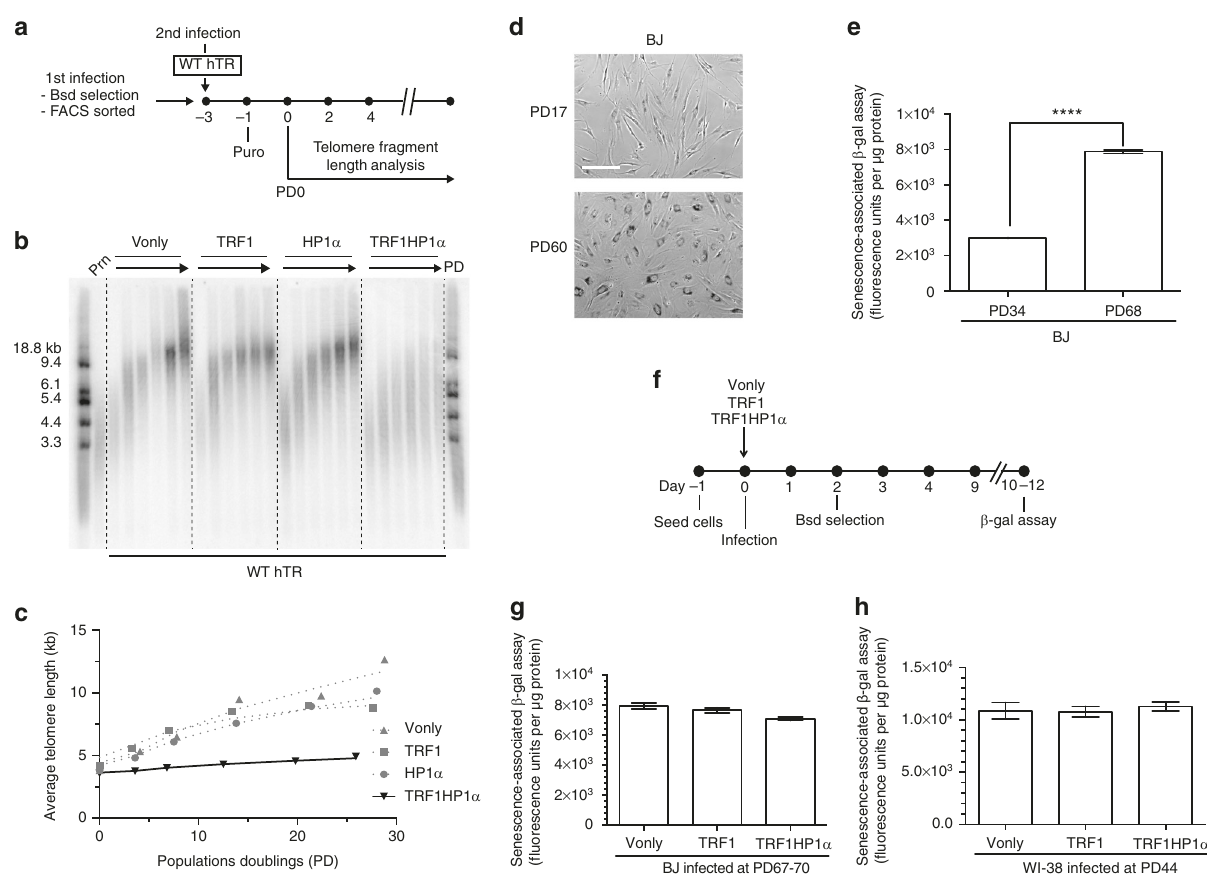
Fig. 2 Telomere-tethered HP1 α attenuates telomere extension by telomerase but does not accelerate replicative senescence. a Experimental set-up to study the impact of HP1 α on telomerase-based telomere extension in UM-UC3. First infection: EGFP-tagged Vonly, TRF1, HP1 α , or TRF1HP1 α . b Telomere length analysis of TRF1HP1 α , various controls, and untreated parental cells (Prn) with WT hTR overexpression from PD0 to ~PD30. c Quanti fi cation (average telomere length) shows TRF1HP1 α attenuates the WT hTR overexpression-induced telomere extension. Similar fi ndings are observed in two independent replicates. d Qualitative β -gal staining of BJ fi broblasts with earlier versus later PD. Bar: 100 µ m. e Quanti fi cations of relative β -gal fl uorescence units are normalized to µ g of protein. BJ PD68 shows signi fi cantly more β -gal fl uorescence than BJ PD34 **** p < 0.0001. Two independent experiments; each contains triplicates. Error bars represent s.e.m. p values are calculated by two-tailed unpaired t test with 95% con fi dence level. f Experimental set-up to determine if TRF1HP1 α accelerates replicative senescence. These analyses were performed only 10 – 12 days after infection, and during that period (~5 – 6 PDs) telomere shortening was minimal. Thus, it is unlikely that the lack of any effect on β -gal was due to adaptive compensation by other proteins or selection of cell subpopulations. Fibroblasts g BJ (PD67-70) or h WI-38 (PD44) show no signi fi cant difference in β -gal signal. BJ, three independent experiments each contain triplicates. WI-38, single experiment with triple replicates. Error bars represent